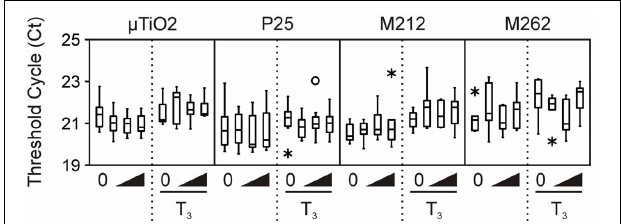
FIGURE 1 | Transcript levels of invariant normalizer gene rpl8 in the µ TiO 2 and TiO2 NP C-fin assays as indicated by the threshold cycle (Ct) values obtained by QPCR. Bevels indicate increasing concentrations of the indicated compound in the absence or presence of T3. The medians are indicated by solid black lines within the boxes, where the box denotes the 25th and 75th percentiles, and the whiskers indicate the minimum and maximum values that lie within 1.5 box-lengths of the median. Outlier (between 1.5 and 3 box lengths) and extreme values ( > 3 box lengths) are shown as open circles or asterisks, respectively.